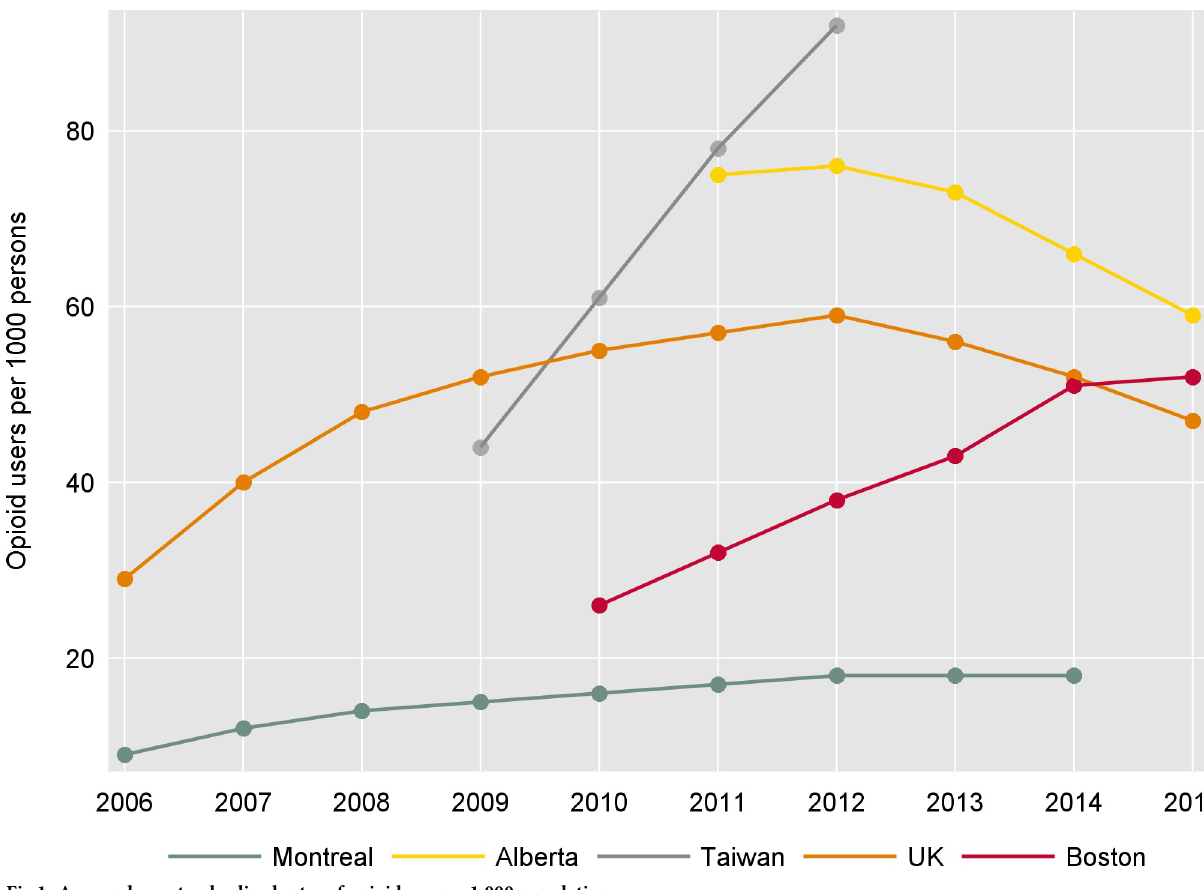
Fig 1. Age- and sex-standardized rates of opioid use per 1,000 population.